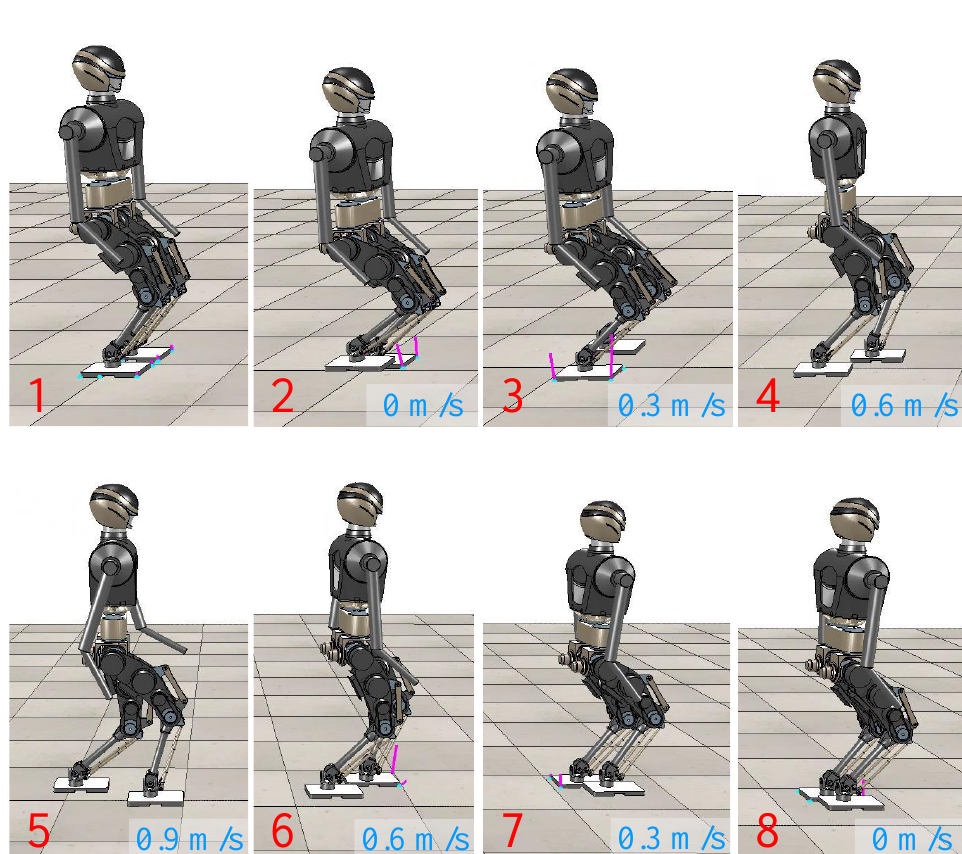
Figure 6. Snapshots of BHR7P running in simulation. The running speed of robot was controlled through online interaction.